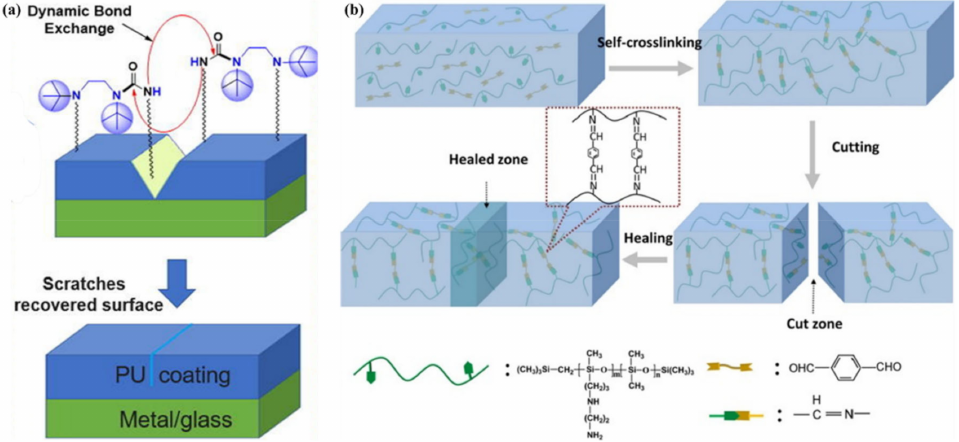
Figure 25. ( a ) Chemistry of the dynamic behavior of the bulky urea bond. Reproduced from [161] with permission from Elsevier. ( b ) Schematic diagram of PDMS synthesis and self-healing process. Reproduced from [162] with permission from Elsevier.